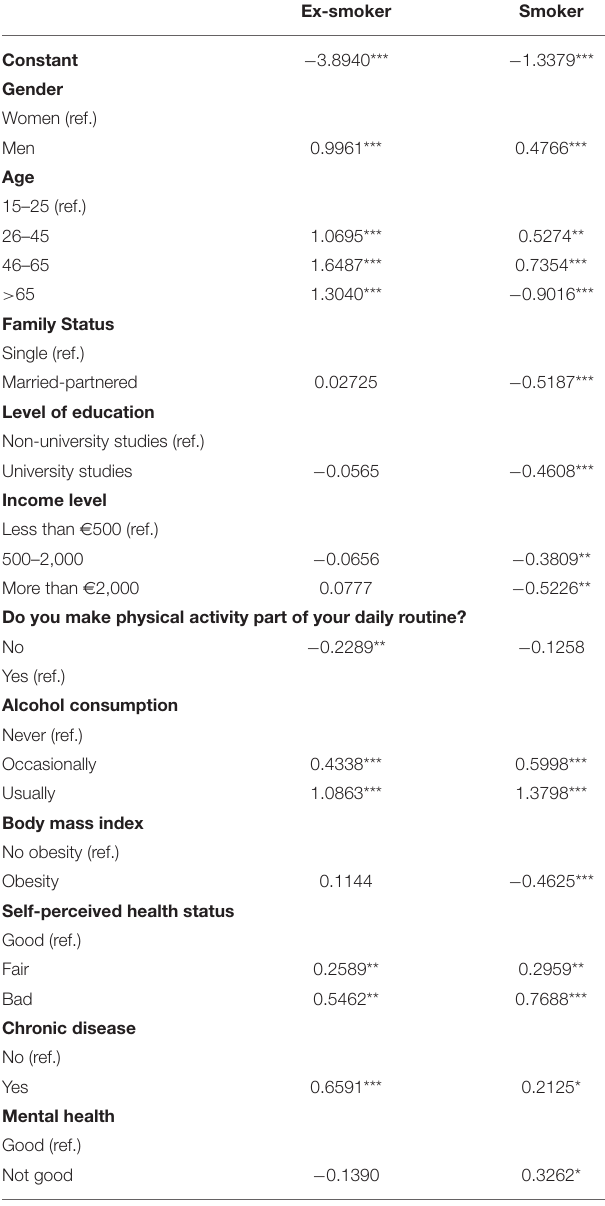
TABLE 2 | Estimates of the multinomial logit